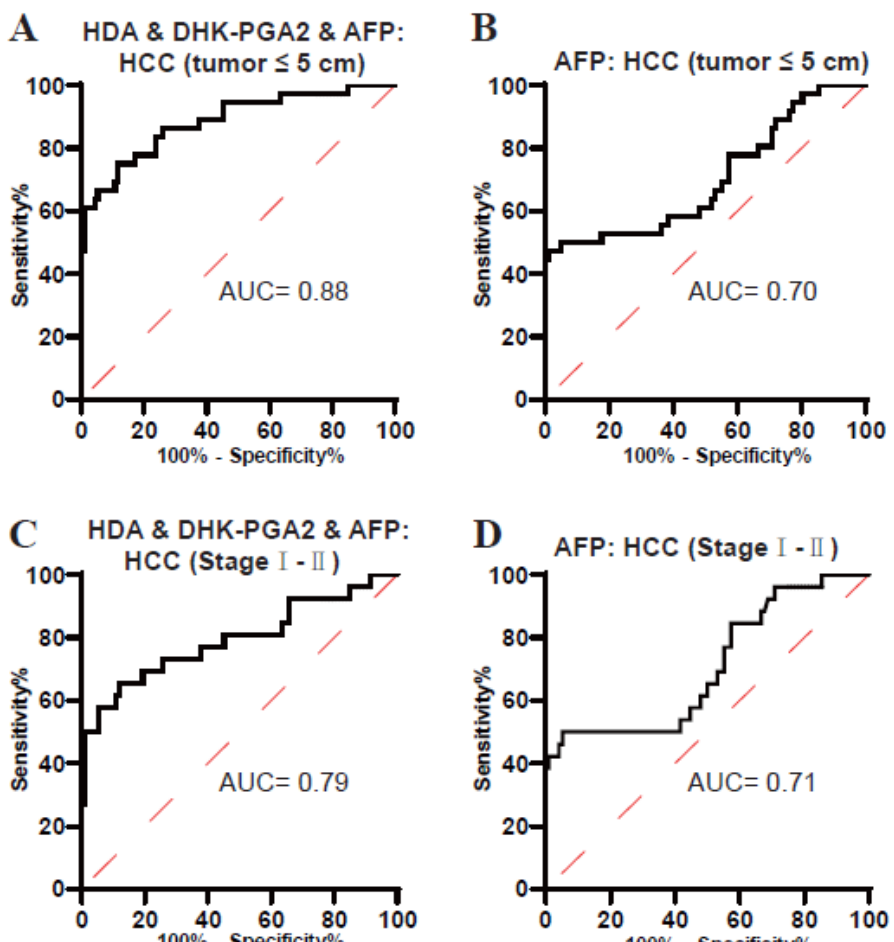
Figure 5. The role of the biomarker signature in the diagnosis of small-size and early-stage T2DM(+) HCC patients. ( A ) The ROC curve of the biomarker signature for discriminating T2DM(+) HCC patients with tumors ≤ 5 cm from T2DM patients. ( B ) The ROC curve of AFP for discriminating T2DM(+) HCC patients with tumors ≤ 5 cm from T2DM patients. ( C ) The ROC curve of the biomarker signature for discriminating T2DM(+) HCC patients with stage Ⅰ - Ⅱ tumors from T2DM patients. ( D ) The ROC curve of AFP for discriminating T2DM(+) HCC patients with stage Ⅰ - Ⅱ tumors from T2DM patients. AFP, alpha-fetoprotein; T2DM, type 2 diabetes mellitus; HCC, hepatocellular cancer; ROC, receiver operating characteristic; AUC, area under the ROC curve.